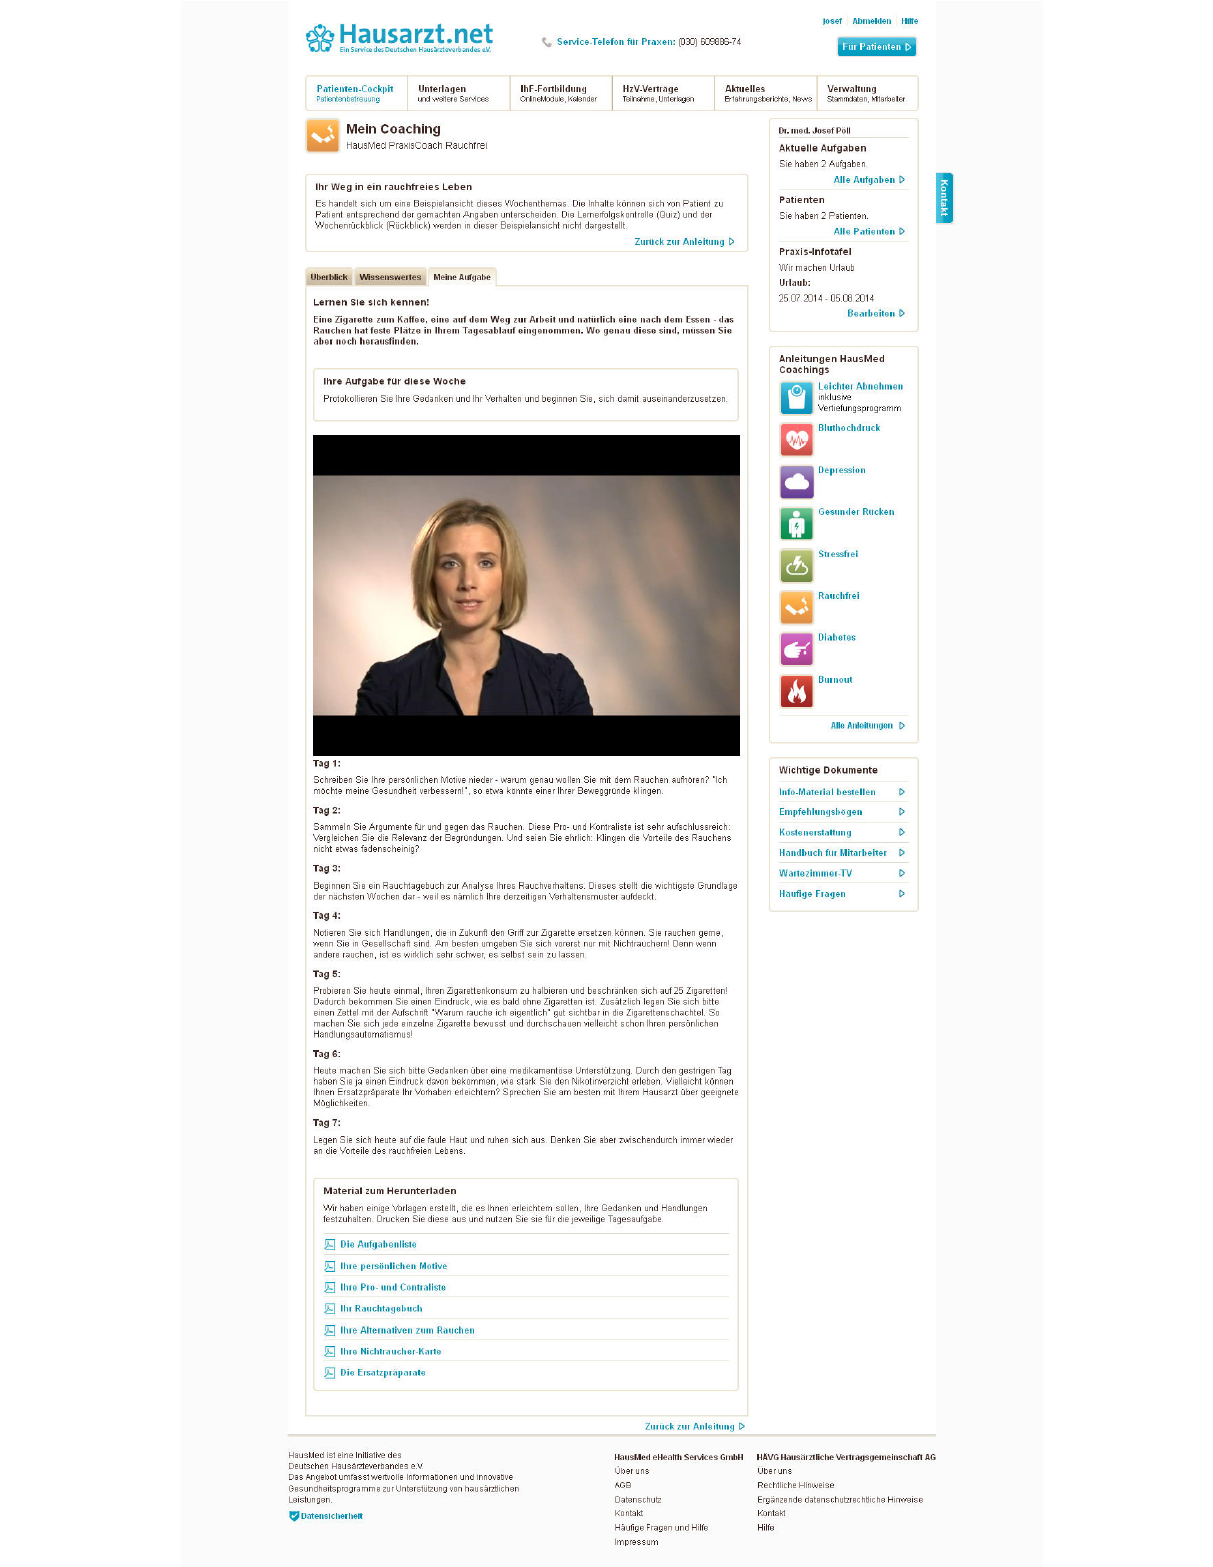
Figure 1. Specific daily tasks including interactive buttons, video clips, and learning progress